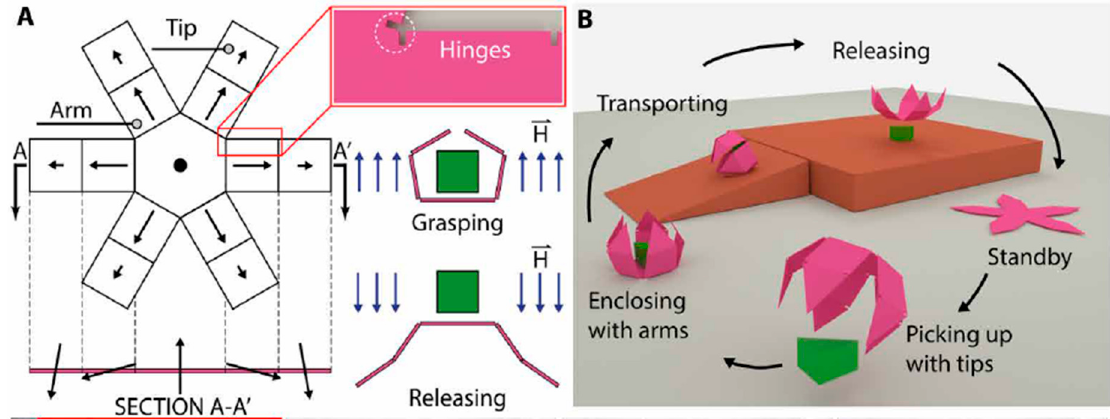
Figure 10. ( A ) Geometry and working mechanism of microgripper; ( B ) the cargo transportation task [45] .